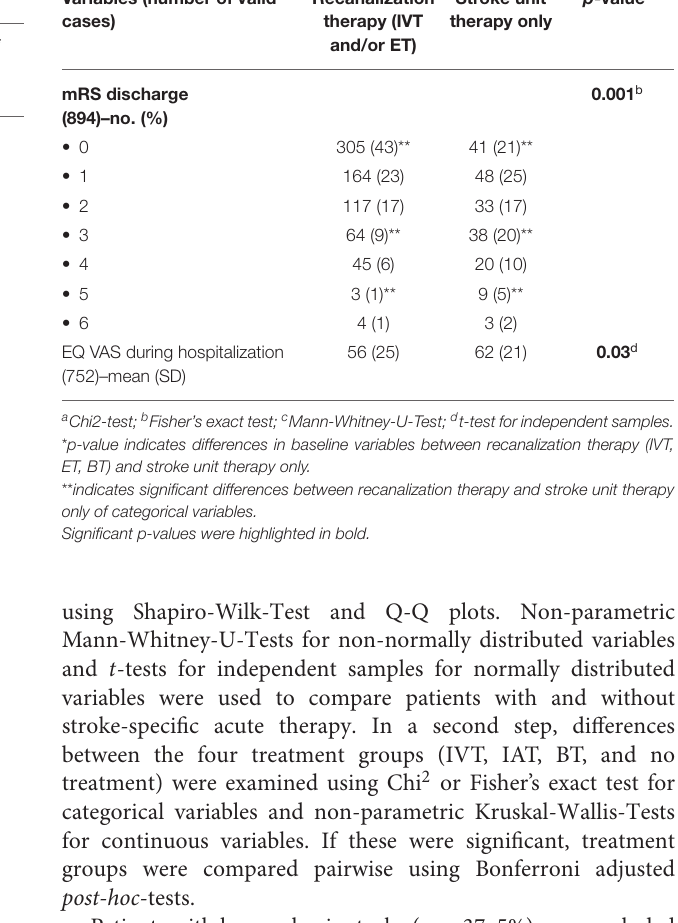
TABLE 1 | Baseline characteristics of stroke patients with and without recanalization therapy [thrombolysis (IVT), endovascular therapy (ET) or bridging therapy